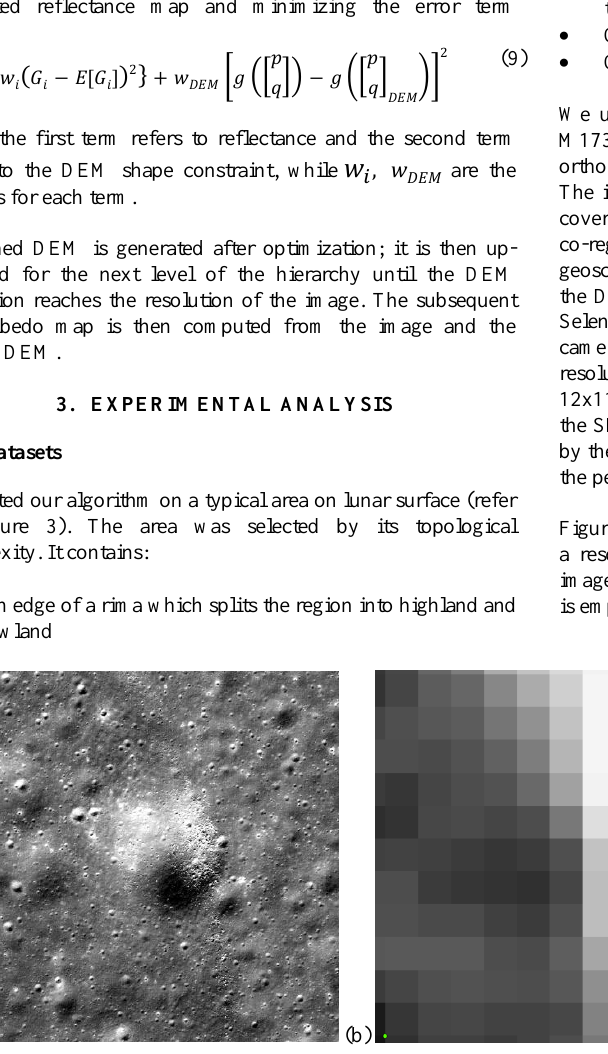
Figure 3. (a) The LRO NAC image (0.5 m/pixel), (b) SLDEM2015 (60-m resolution); and (c) NAC DEM (3-m resolution) for comparison